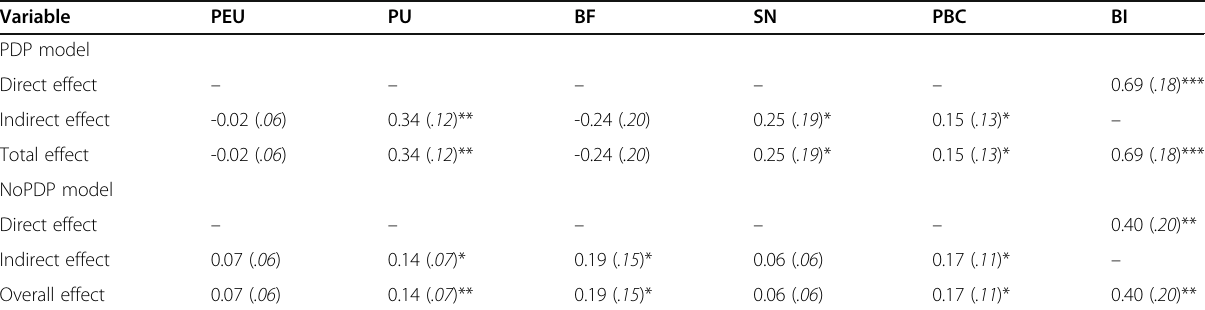
Table 7 Direct, indirect, and overall effects of the latent variables on SRB by group Variable PEU PU BF